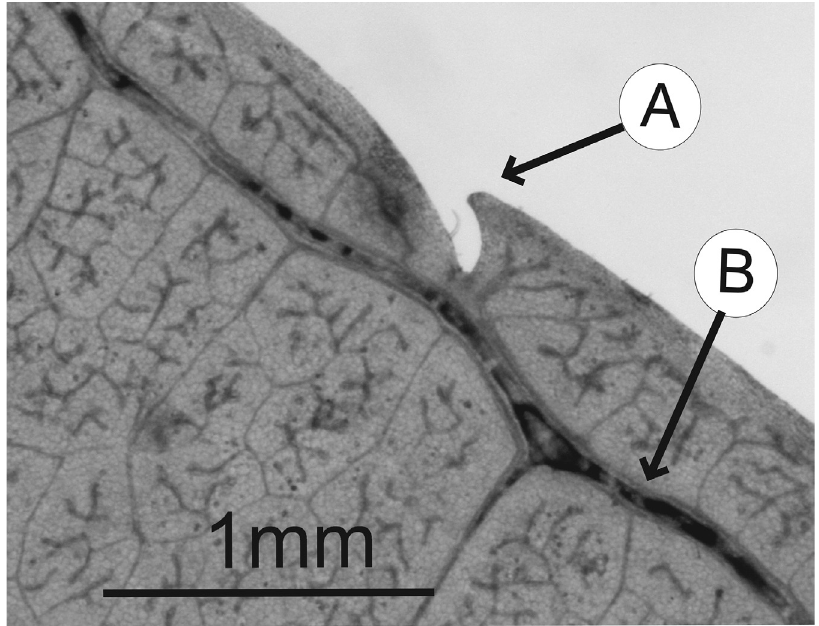
Figure 3. Leaf architecture of Spondias purpurea . A Concave-convex tooth B Intramarginal vein (from Madsen 63428 , NY).